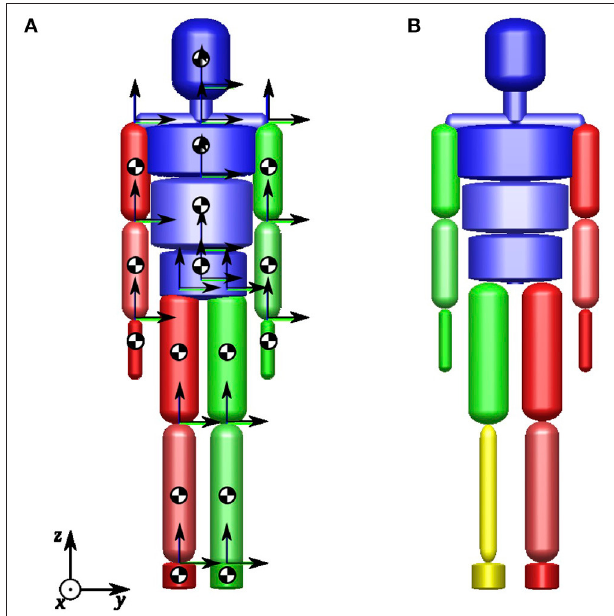
FIGURE 2 | Multibody models of the full human body: (A) Full human body with segment COM positions and local coordinate frames, (B) Full human body with transfemoral prosthesis (yellow).